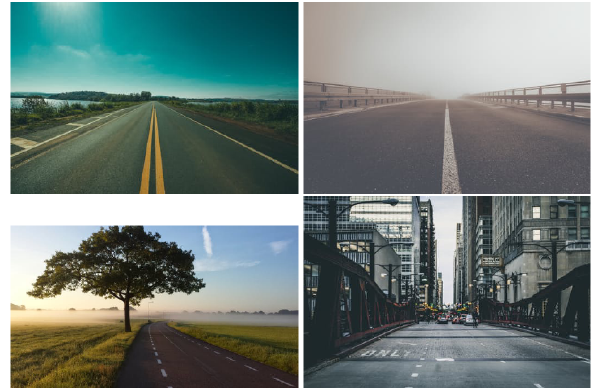
Figure 2. The road marks are different depending on the road type and the regulations of the country the road located. The road boundaries can be marked in yellow or white and solid or dashed lines. Some roads may not have proper road marks (courtesy of